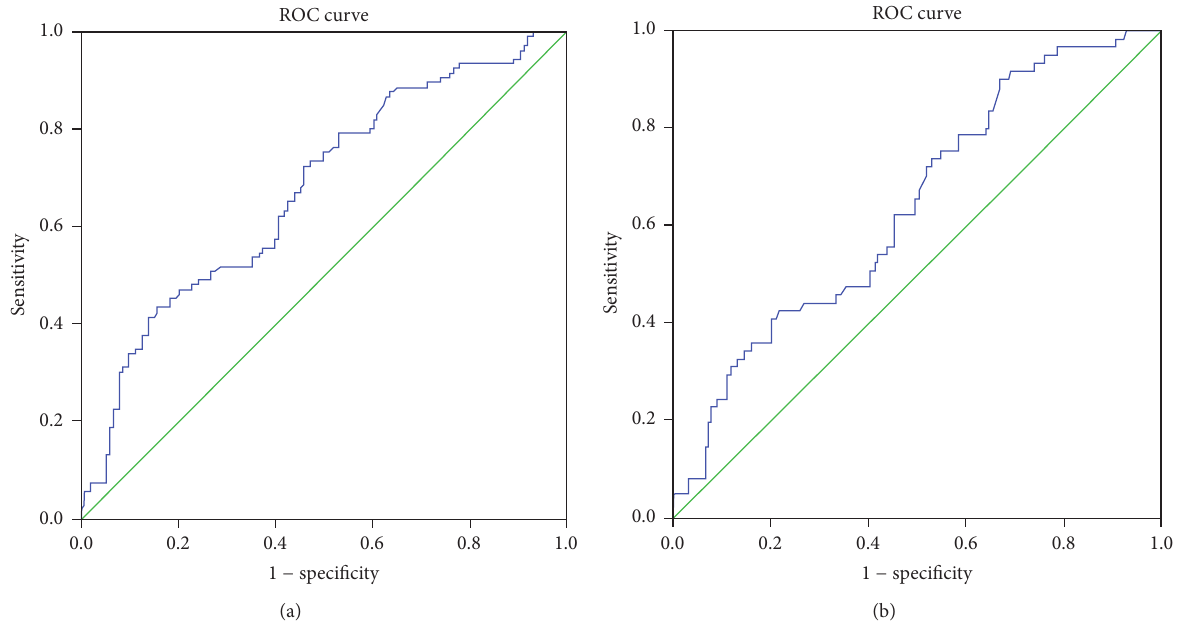
Figure 2: (a) Receiver Operating Characteristic (ROC) curve of soluble HLA-G with heart failure defined as ejection fraction < 50%. Area under the curve is 0.676, 𝑝 < 0.001 . (b) Receiver Operating Characteristic (ROC) curve of soluble HLA-G with heart failure defined as ejection fraction < 40%. Area under the curve is 0.639, 𝑝 = 0.001 .